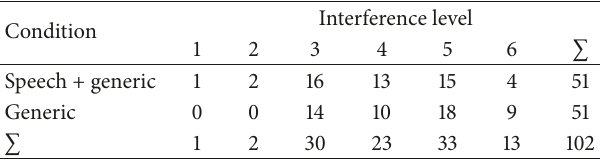
Table 4: Behavioural observations during system manoeuvres; categories: (1) not distracted, (2) no reaction, continuation of NDRT, (3) short glance ahead, continuation of NDRT, (4) alternating of NDRT and looking ahead, (5) interruption of NDRT and looking ahead with magazine in hand, and (6) interruption of NDRT and looking ahead, putting magazine